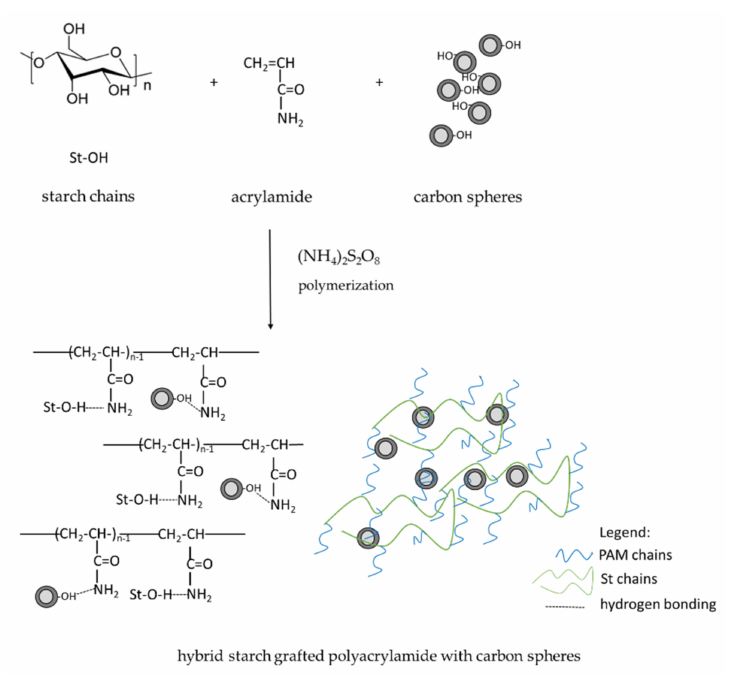
Scheme 1. Schematic illustration of starch grafting polyacrylamide reaction with visualization of hybrid